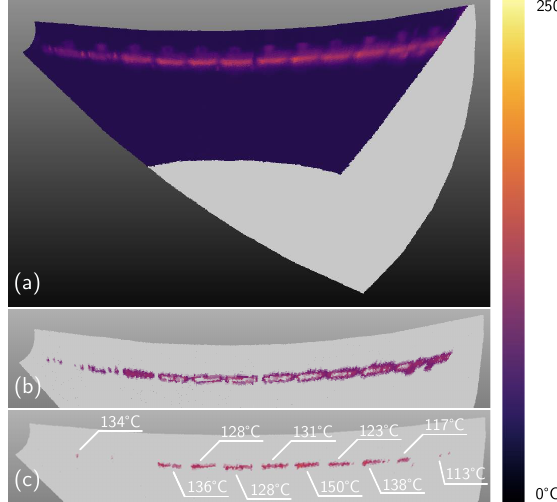
Figure 13. Post-processed 3D models that visualize local maximum surface temperatures ( T S ) during the continuous welding process stage. (a) depicts raw results, (b) T S ∈ [75 ° C , 110 ° C] , and (c) T S > 110 ° C with area-wise maxima labelled in